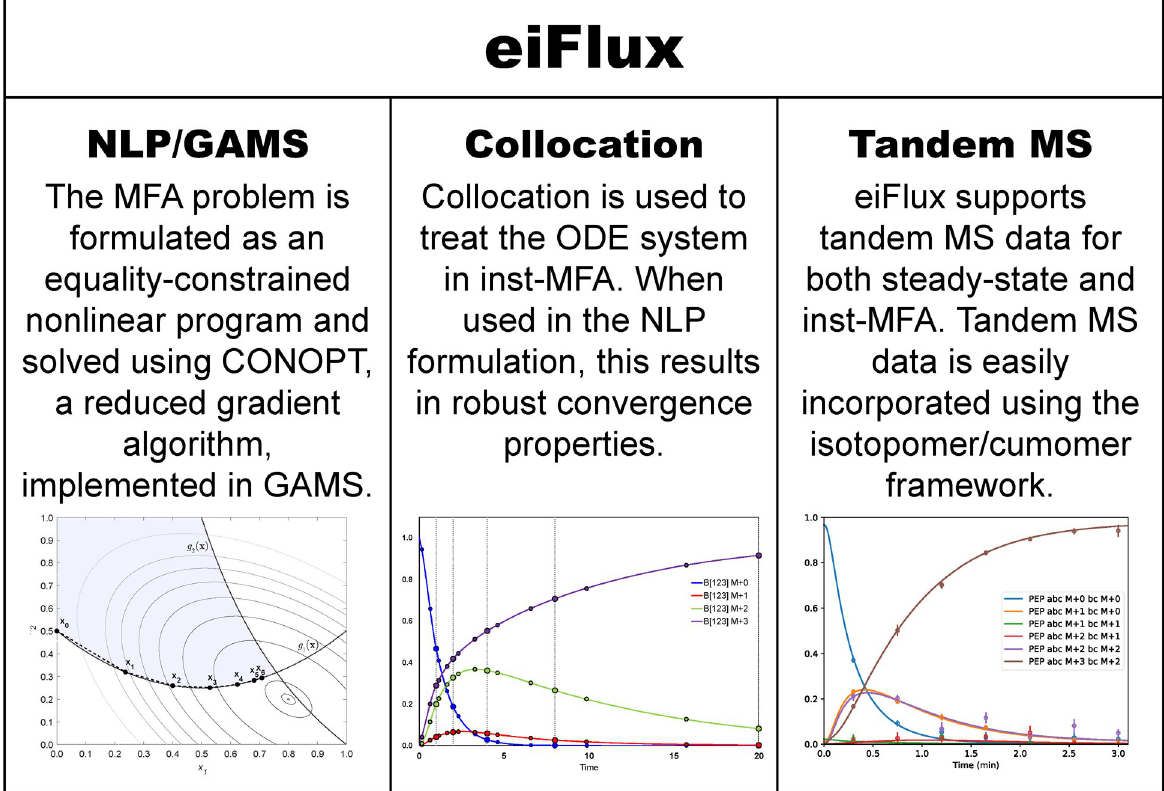
Fig 1. Several factors make eiFlux unique among currently available MFA software. eiFlux uses equality-constrained nonlinear programming to solve both the steady-state and inst-MFA problems. Treating the ODE system using collocation in an NLP formulation results in robust convergence properties. eiFlux, which supports the cumomer modeling approach, may directly fit tandem MS data.